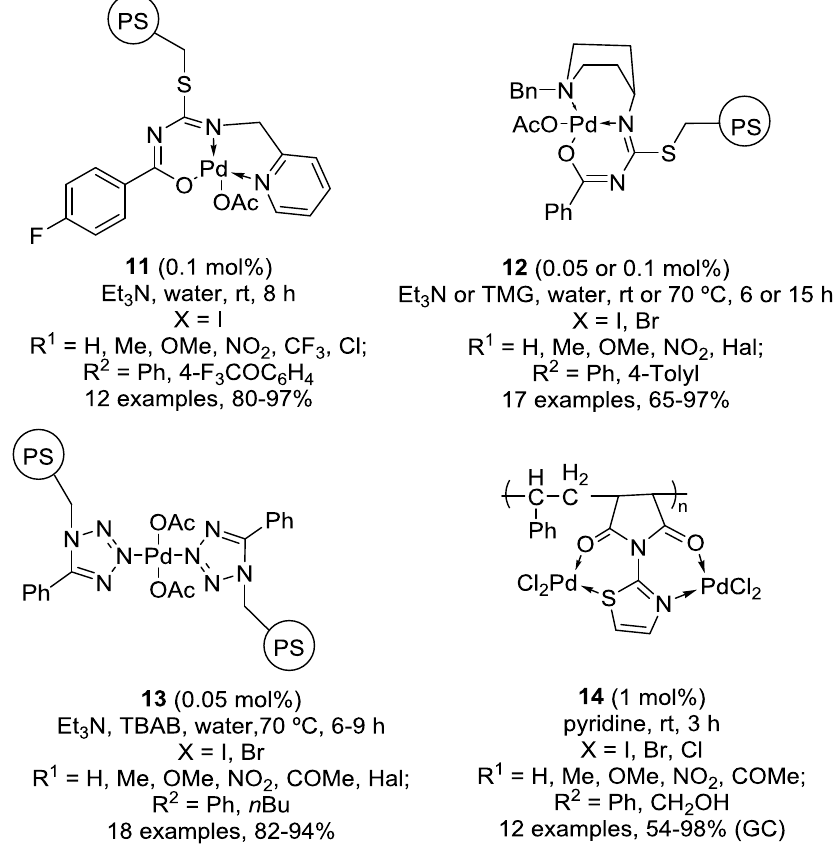
Figure 4. Polystyrene-and co-polymeric styrene-supported catalysts for the Sonogashira reaction in water. Conditions, substrate scope and yield range (Scheme 2).